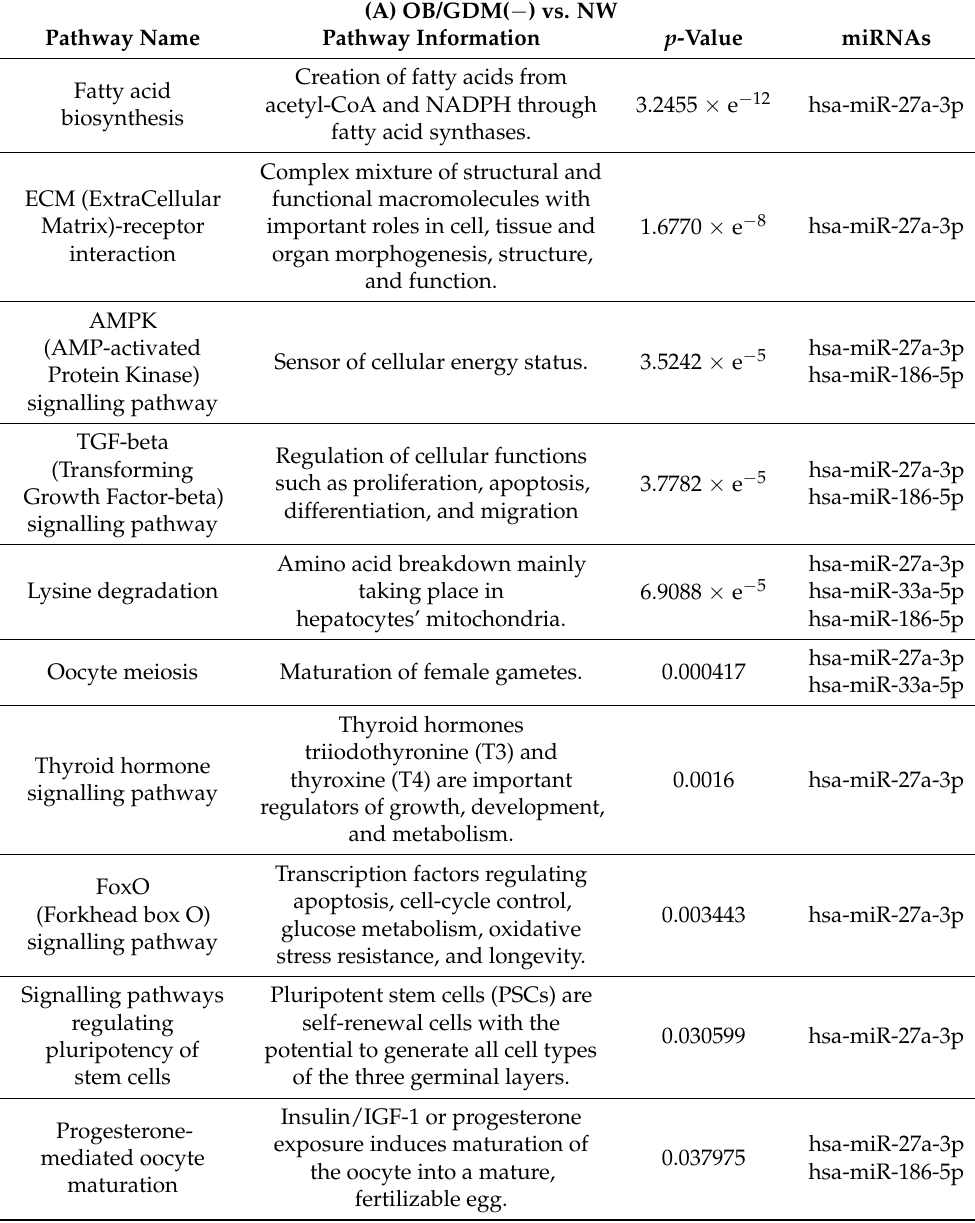
Table 3. Selected pathways coherent with the context of this study, from the union analysis performed with DIANA–miRPath v.3, for each comparison: (A) OB/GDM( − ) vs. NW, (B) OB/GDM(+) vs. NW, (C) OB/GDM(+) vs. OB/GDM( −